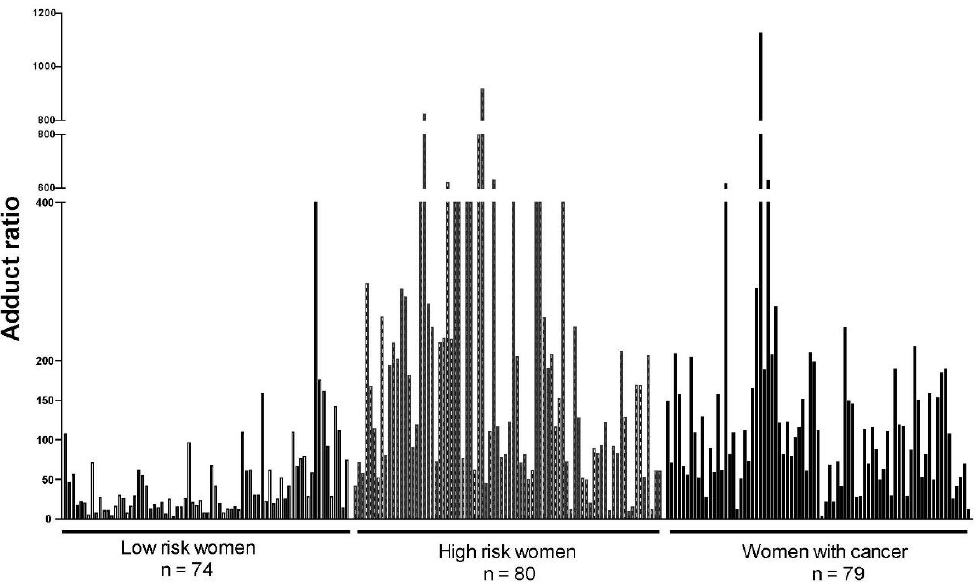
Figure 3. Ratios of depurinating estrogen-DNA adducts to estrogen metabolites and conjugates in serum of women at low risk, women at high risk and women diagnosed with breast cancer ( p < 0.0001) [46].